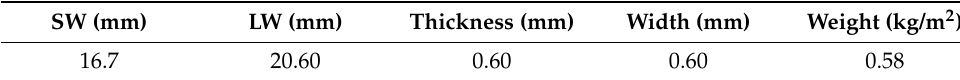
Figure 13. GFRP. Table 4. Properties of steel wire meshes.